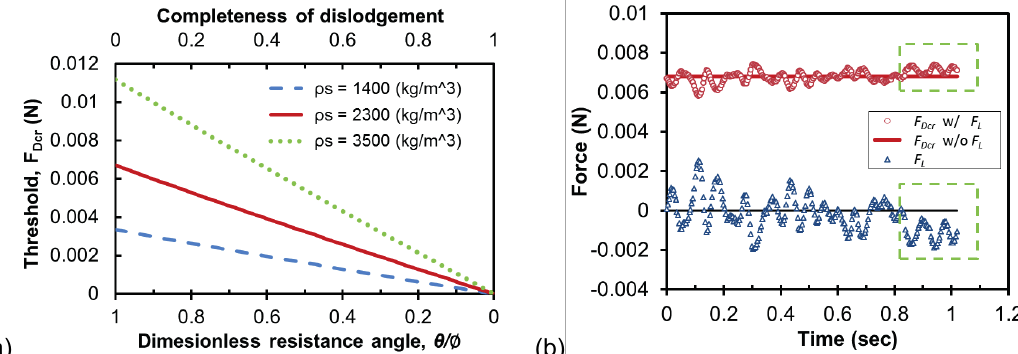
Fig. 4 (a) Dynamic particle resistance. (b) The effect of lift forces on